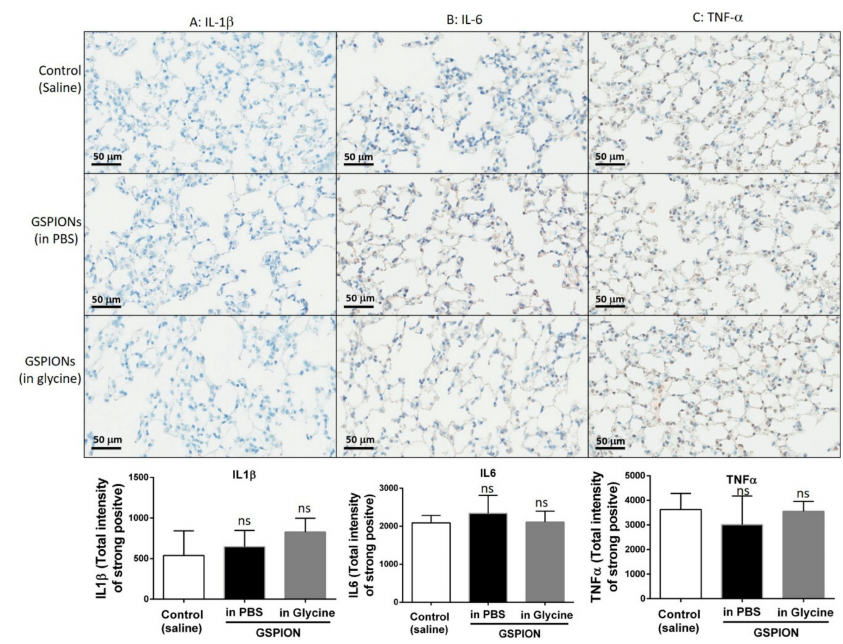
Figure 4. GSPIONs do not increase expression of pro-inflammatory cytokines in lung parenchyma. In comparison to control (saline), expression of pro-inflammatory cytokines, ( A ). IL-1 β , ( B ). IL-6 and ( C ). TNF; was unchanged along with negligible damage in the lung parenchyma. Scale bars represent 50 µ m. N = 6 mice / group, Mean ± SEM. A one-way ANOVA was used to determine the significance in between di ff erent groups. Each group was quantified for strong positive expression by analyzing 10 sections / lung / group. ns, non-significant